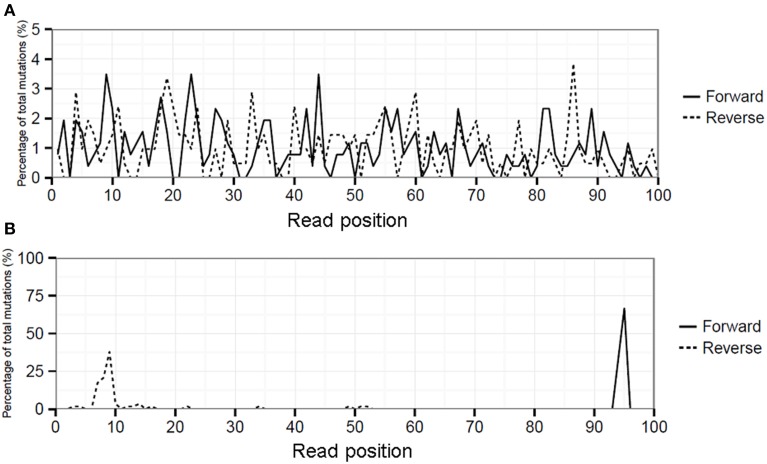
Hairy caterpillar plot (HCPP) of RT-PCR 1 influenza position PA-1976 (A) which showed that mismatches at this position were spread evenly over all read positions and strand orientations, indicative for an actual biological variation. At position PA-2189 (B) the mismatches were predominantly present at specific read positions in both strand orientations indicative for artificial variation.